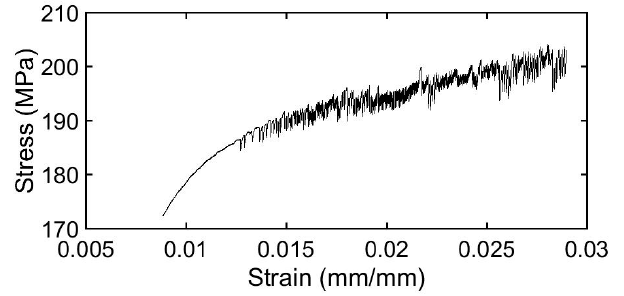
Figure 5. Typical plastic region of the stress-time curve observed in the studied specimens.